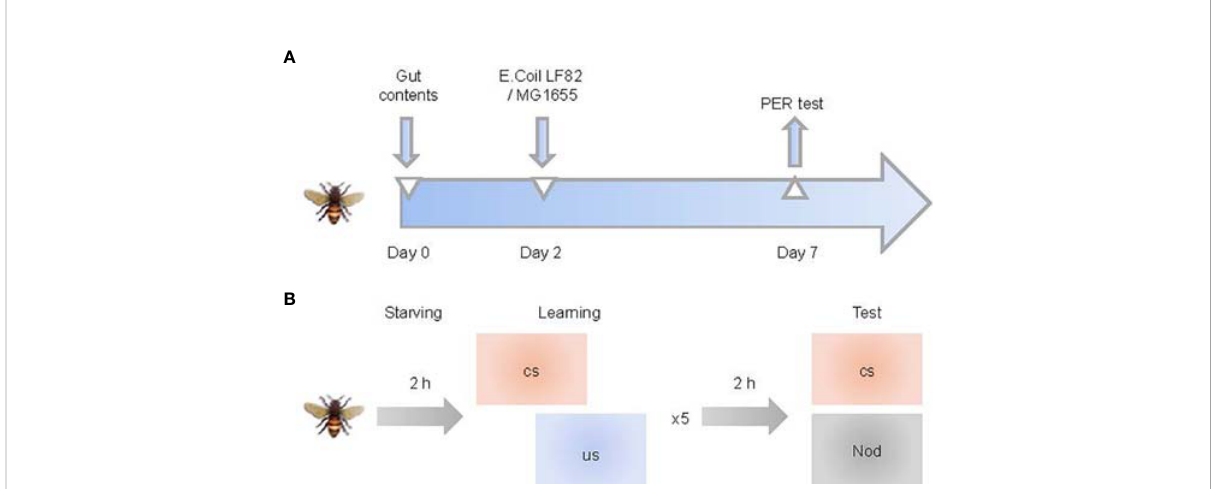
FIGURE 1 Study pipeline. (A) Schematic illustration of experimental design. Honeybees (0 – 1 day old) were fed with sucrose water-mixed communities from whole-gut contents and sterile pollen for two days and then orally exposed with Escherichia coli for fi ve days. (B) Training and